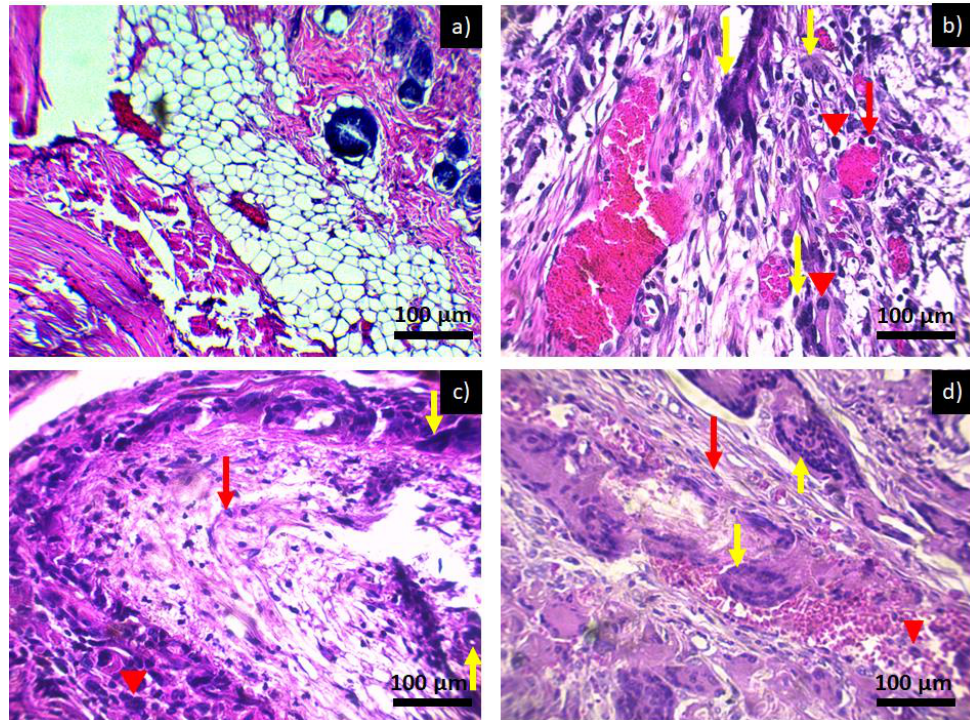
Figure 6. Histological preparation in tissue hematoxylin-eosin with the PCL: ( a ) control, ( b ) PCL 2 weeks, ( c ) PCL 4 weeks, and ( d ) PCL 6 weeks. Red arrows indicate the presence of lymphocytes, red arrowheads indicate macrophages, and yellow arrows indicate the presence of multinucleated giant cells characteristic of a chronic inflammatory infiltrate.